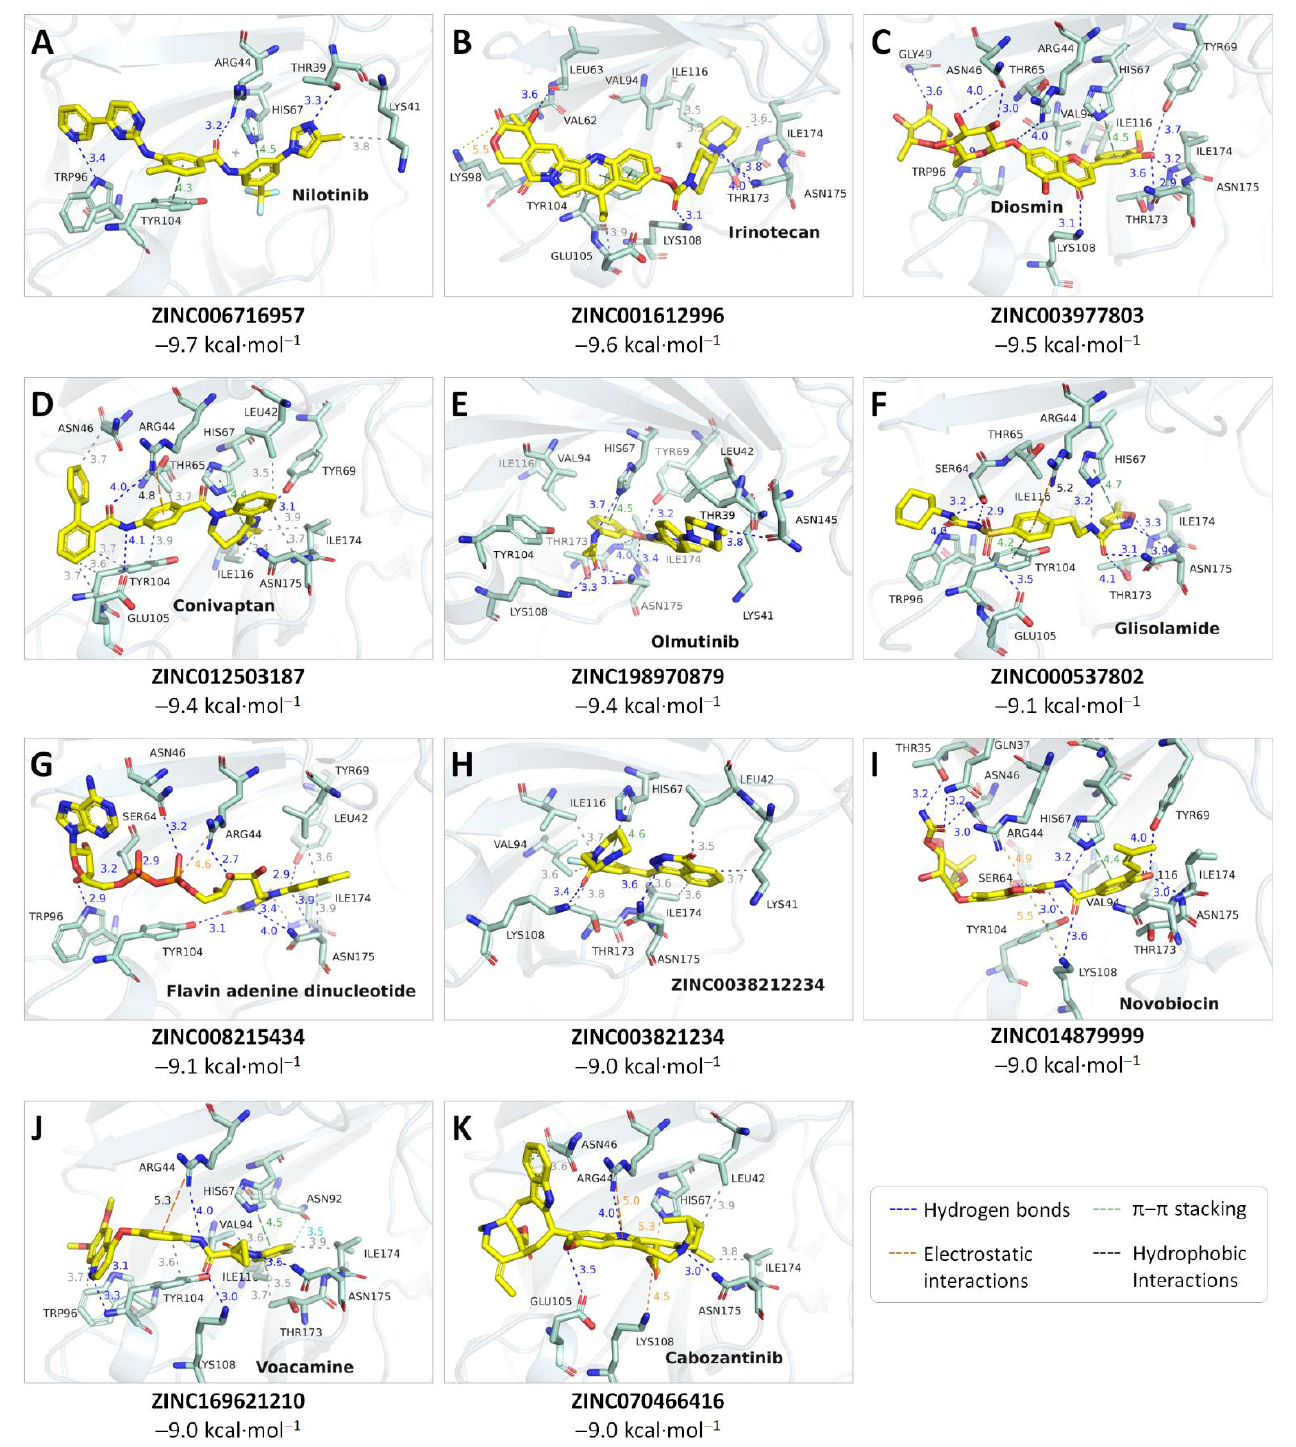
Figure 4. Interactions of the top 11 small-molecule drugs with the MPXV E8 protein obtained by molecular docking. The hydrogen bonds are shown as blue, the π – π stacking (including parallel or perpendicular stacking patterns) is shown as green, the electrostatic interactions (including salt bridges and π – cation interactions) are shown as orange, and the hydrophobic interactions are shown as grey.